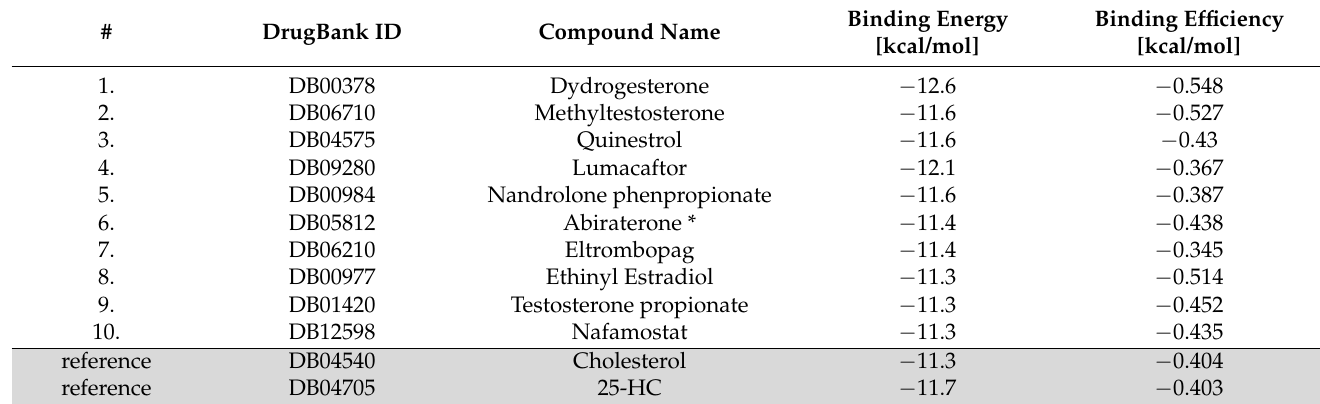
Table 1. The list of the top hit compounds obtained from in silico